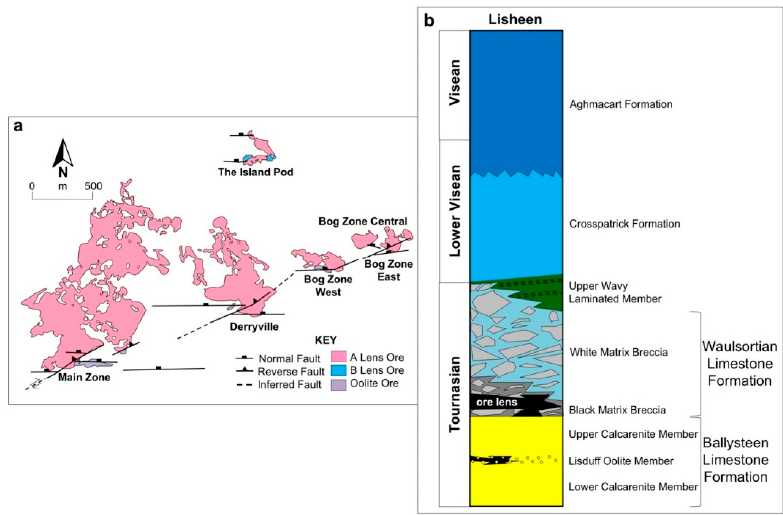
Figure 4. Geology of the Lisheen deposit. ( a ) Map projection of the top surface of the Lisheen deposit, including the different orebodies and main structural features (modified from Kyne et al. [44]. ( b ) Stratigraphic column of the Lisheen area showing the ore lens and hosting rocks (modified from Wilkinson et al. [45]).